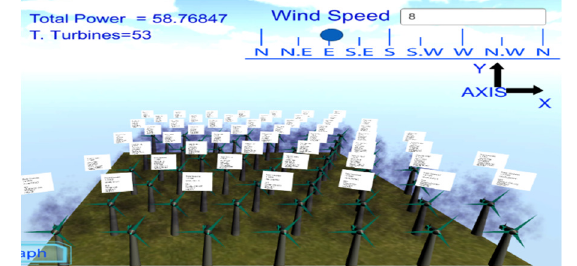
In Table 2, positions of turbines along X-axis and Y- axis in grid based layout are given. X: 1280, Y: 0 represents the turbines of third column and first row respectively.